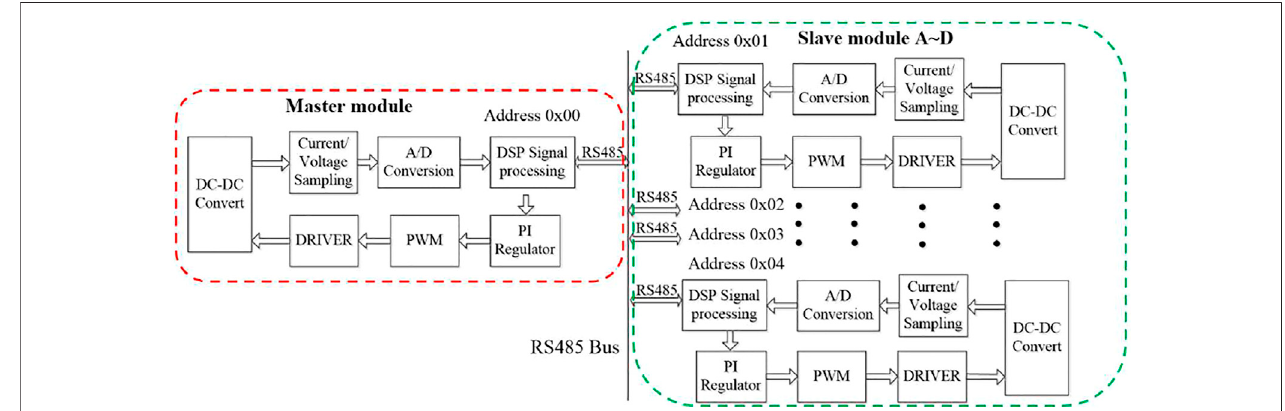
FIGURE 15 | Design of the secondary side digital current sharing the control system.